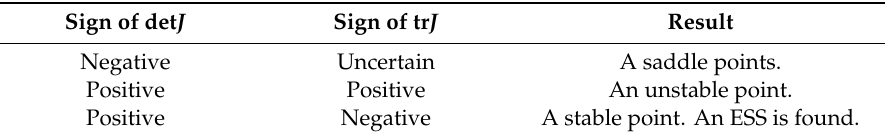
Table 3. Judging standard of ESS.